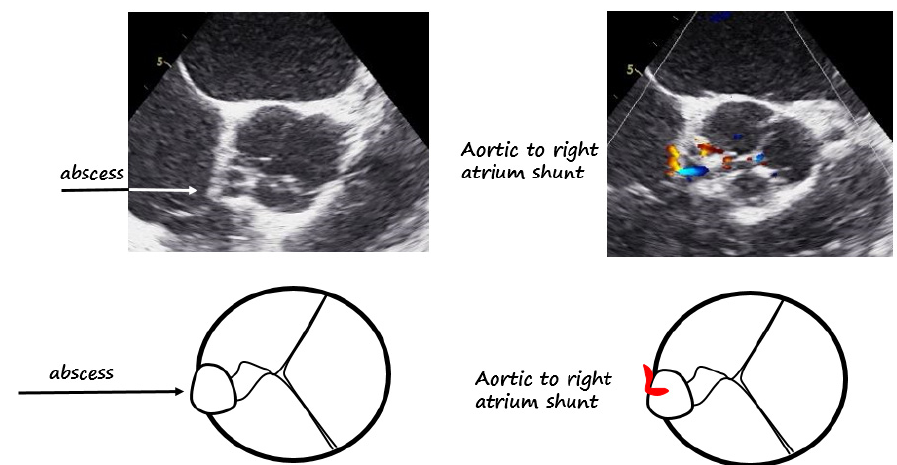
Figure 1. First TEE at the time of acute aortic regurgitation presentation . Top left panel shows TEE at level of aortic valve; a shaggy, pedunculated mass [1] is attached to the aortic wall; bottom left panel shows the relative scheme. Top right panel shows TEE at same level in diastole, with vegetation impeding correct valve closure and a suspected aortic wall infiltration; bottom right panel shows the relative pictogram.